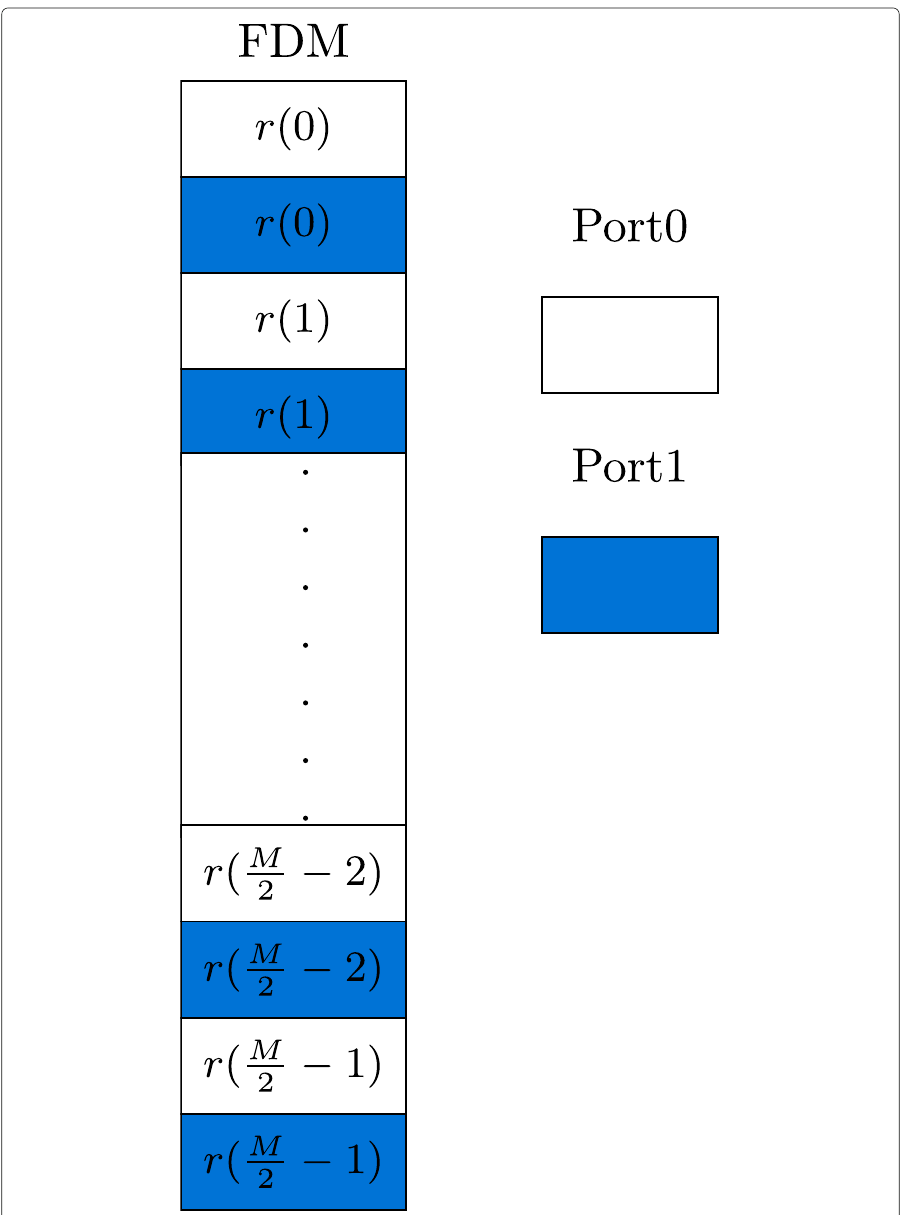
Fig.3 Port mapping for FDM method of reference signal multiplexing for MIMO stream transmissions in 3GPP